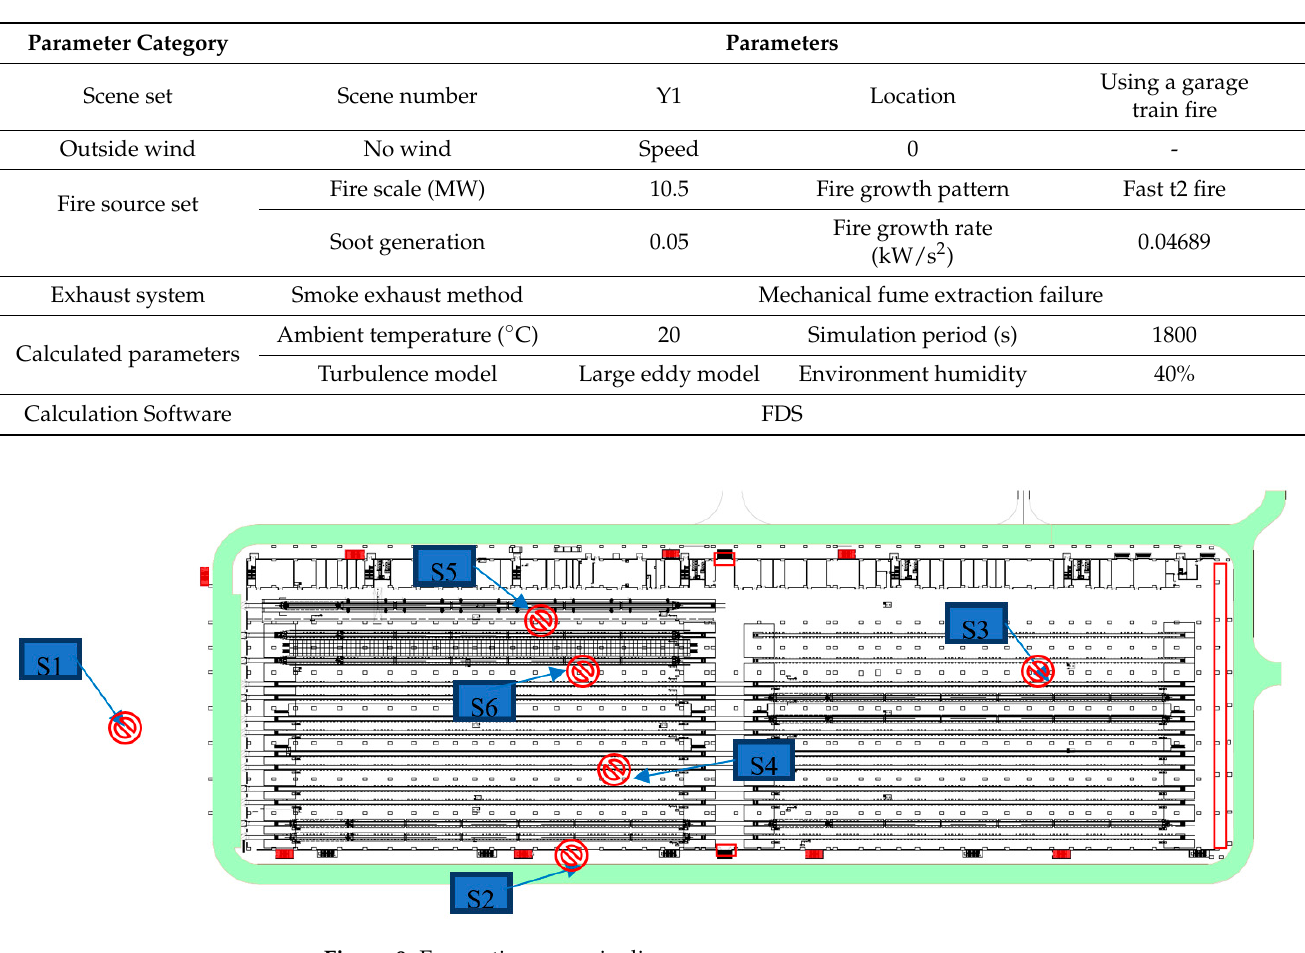
Figure 9. Evacuation scenario diagram. Table 11. Smoke scene Y1 parameters.